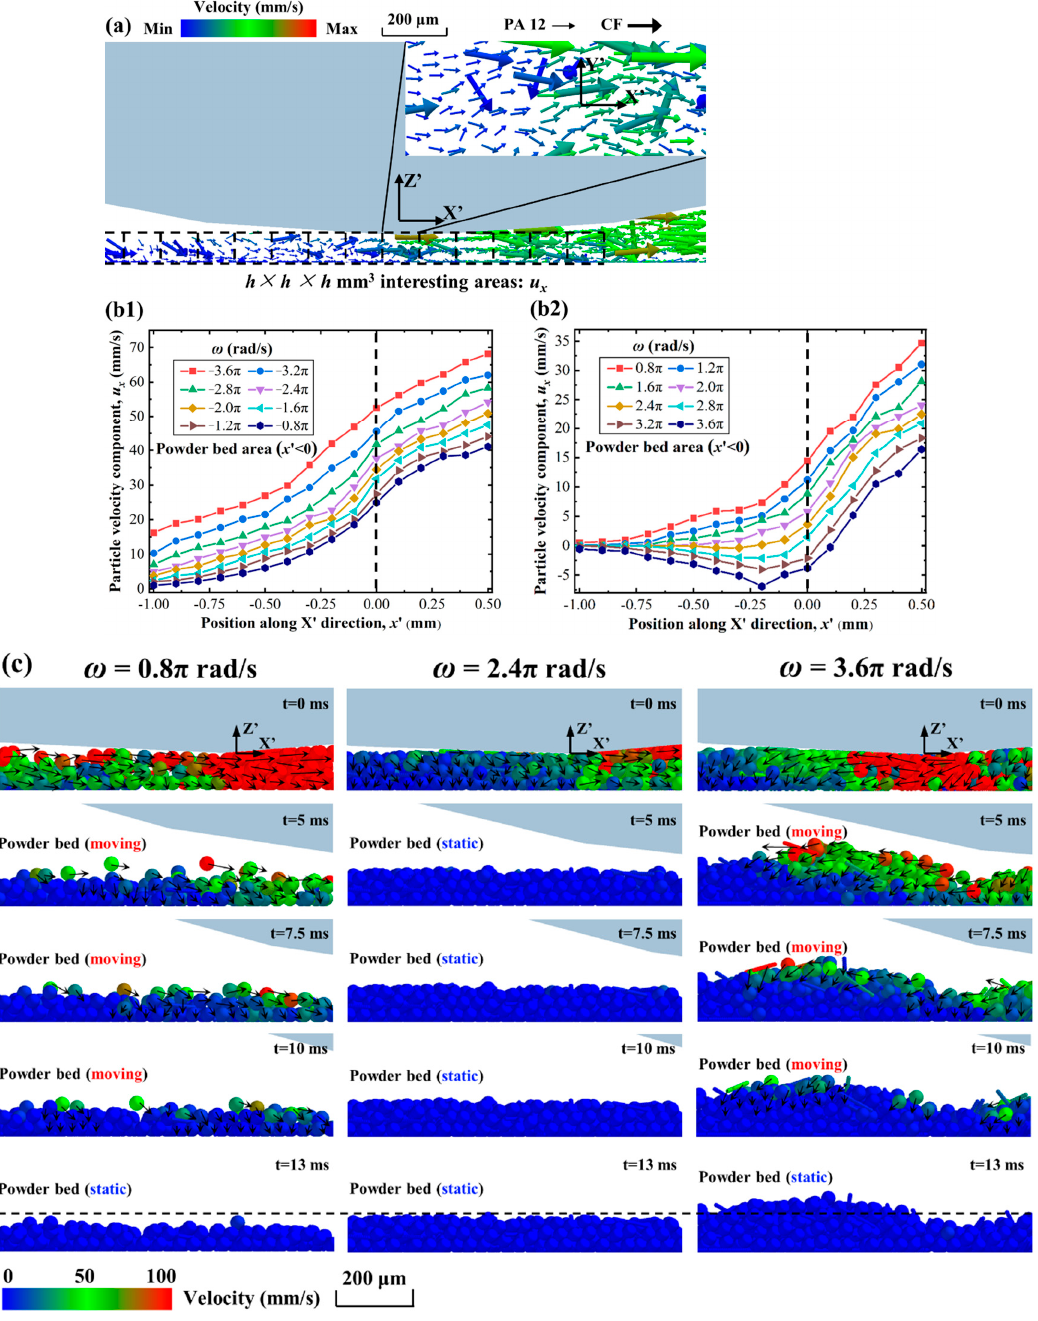
Figure 7. DEM results showing the composite powder motion and deposition processes: ( a ) example of particle velocity profile along the “interesting areas”; particle velocity profiles at different rotation speeds from ( b1 ) counter-rotating mode to ( b2 ) forward-rotating mode; ( c ) detailed composite particle deposition process at different rotation speeds in forward-rotating mode.